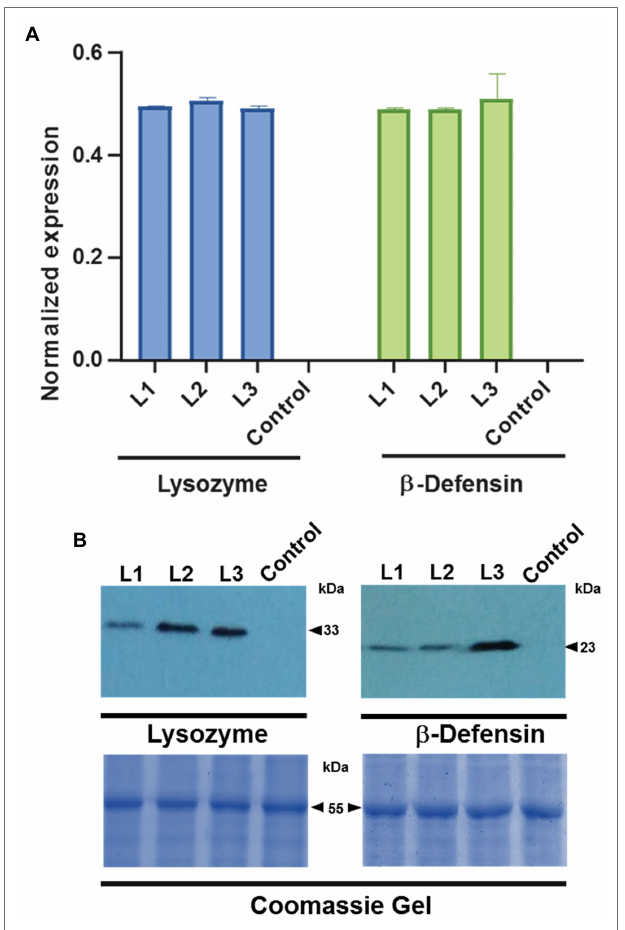
FIGURE 3 | Detection of transcripts and fused proteins in Citrus plantlets. Three independent lines (L1-3) of plants transformed with lysozyme or β -defensin were analyzed. (A) RT-qPCR detection of CsPP16-lysozyme (left graph), and equivalent assay in CsPP16- β -defensin expressing plants (right graph). Relative expression was normalized with the COX transcript. Control, wild type Citrus was employed in both analyses. (B) Western blot analysis to detect the fused proteins in three independent transformants for lysozyme (left image) with a MW of 33 kDa and β -defensin (right image) with a MW of 23 kDa. Coomassie-brilliant-blue-stained SDS-PAGE gels indicating Rubisco Large Subunit ( ≈ 55 kDa) are shown as loading